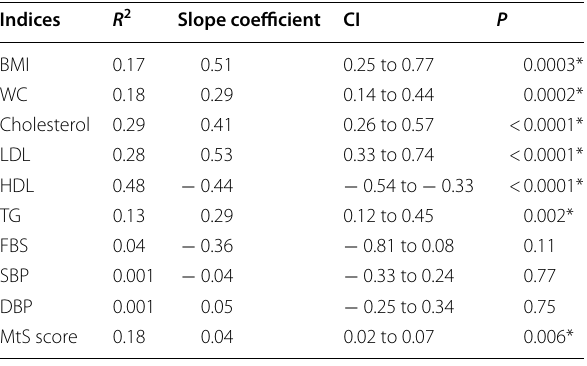
Table 5 Regression of SGA treatment duration and metabolic syndrome